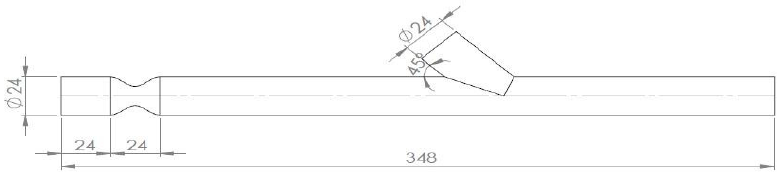
Figure 1. Geometry sketch.